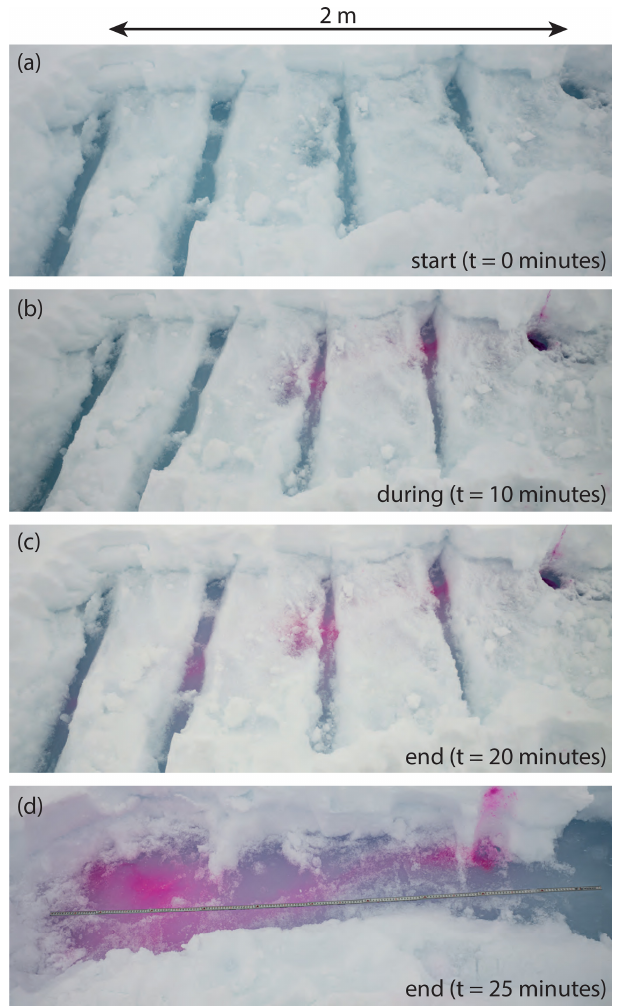
Figure 11. Results from an RWT dye tracing experiment, show- ing the monitored site at the time of dye injection (a) , halfway (b) and at the end of the experiment before (c) and after (d) full expo- sure of the flow path. Rhodamine WT was injected in the borehole (in the top right corner of the image, located upstream). Note that in panel (d) the snow was also excavated uphill from the insertion